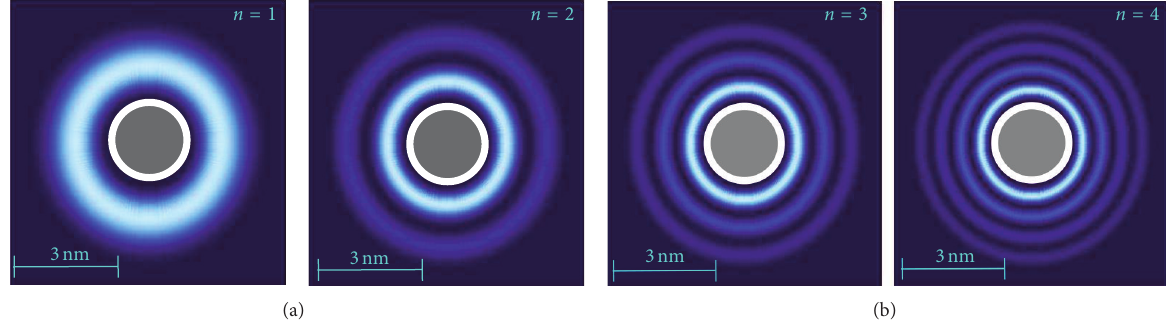
Figure 4: Probability density plots for |Ψ 𝐿,𝑛 (𝑟 0 )| 2 /𝑟 2 0 when 𝐿 = 2 and 𝑛 = 1, 2 (a) as well as 𝑛 = 3, 4 (b), where 𝑛 labels the eigenstates, for a spherical shell of radius 𝑅 = 10 ˚A. The wave function Ψ 𝐿,𝑛 (𝑟 0 ) is a solution of the one-dimensional Schr¨odinger equation with effective (𝑟 ,𝜃 = 𝜋/2) shown in Figure 2. We chose 𝜖 potential 𝑉 0 eff surrounding